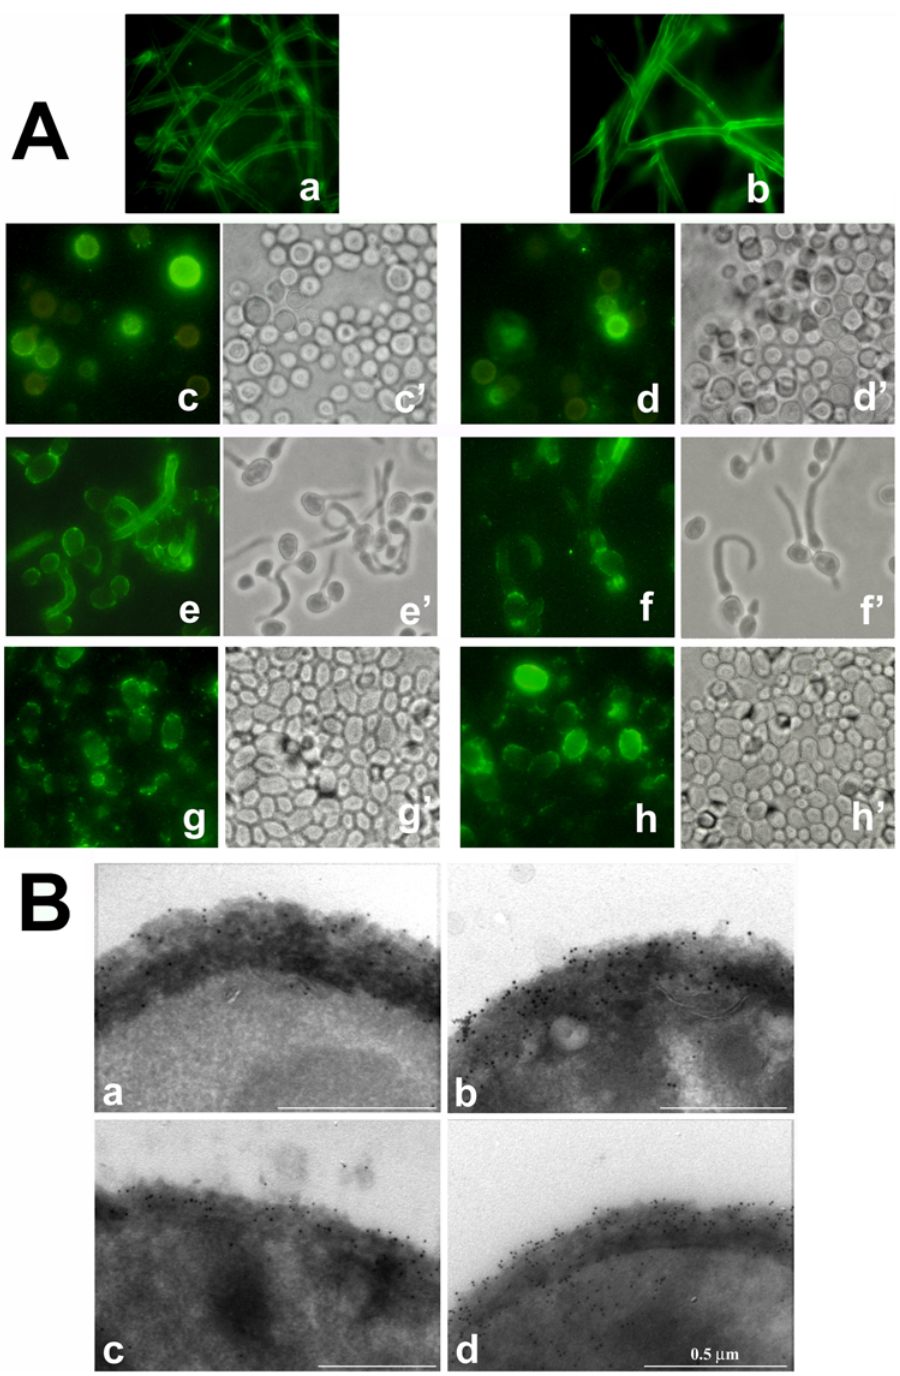
Figure 1. Expression of anti- b -glucan mAb epitopes in major fungal pathogens for humans. Panel A: immunofluorescence staining pattern of hyphal filaments of Aspergillus fumigatus (a, b), Cryptococcus neoformans cells (c, d) and C. albicans germ-tubes (e, f) or yeast cells (g, h) reacted with the IgG (a, c, e, g) or the IgM (b, d, f, h) anti- b -glucan mAb. Sub-panels c 9 through h 9 show the corresponding bright field images. Magnification: 800 6 times ( except A. fumigatus hyphae, magnified 400 6 times). Panel B: ultrathin sections from cryofixed yeast (a,b) or hyphal (c,d) cells of C. albicans after immunogold labelling with the IgG (a,c) or the IgM (b, d) mAb.